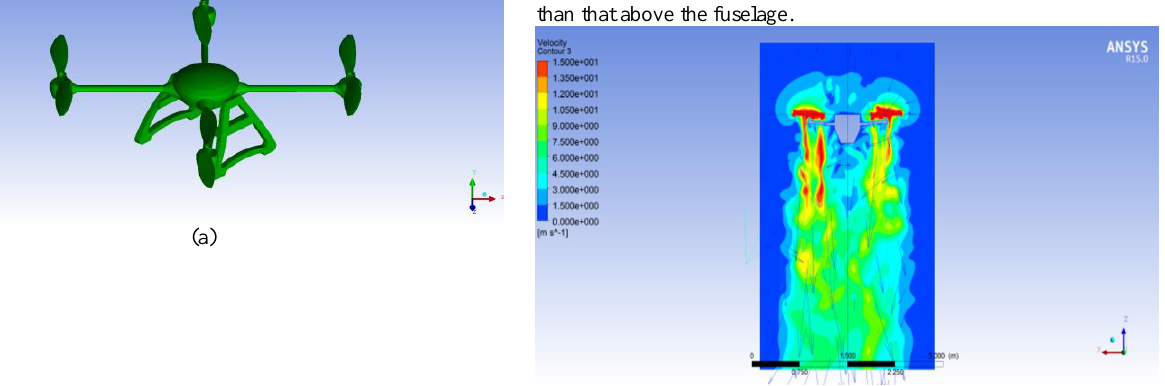
Figure 3. The distribution of airflow and flow